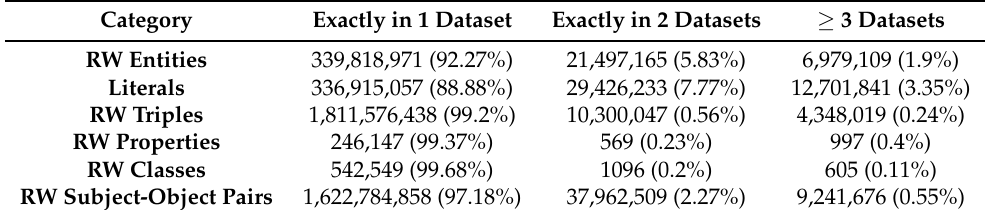
Table 9. Elements per number of datasets.